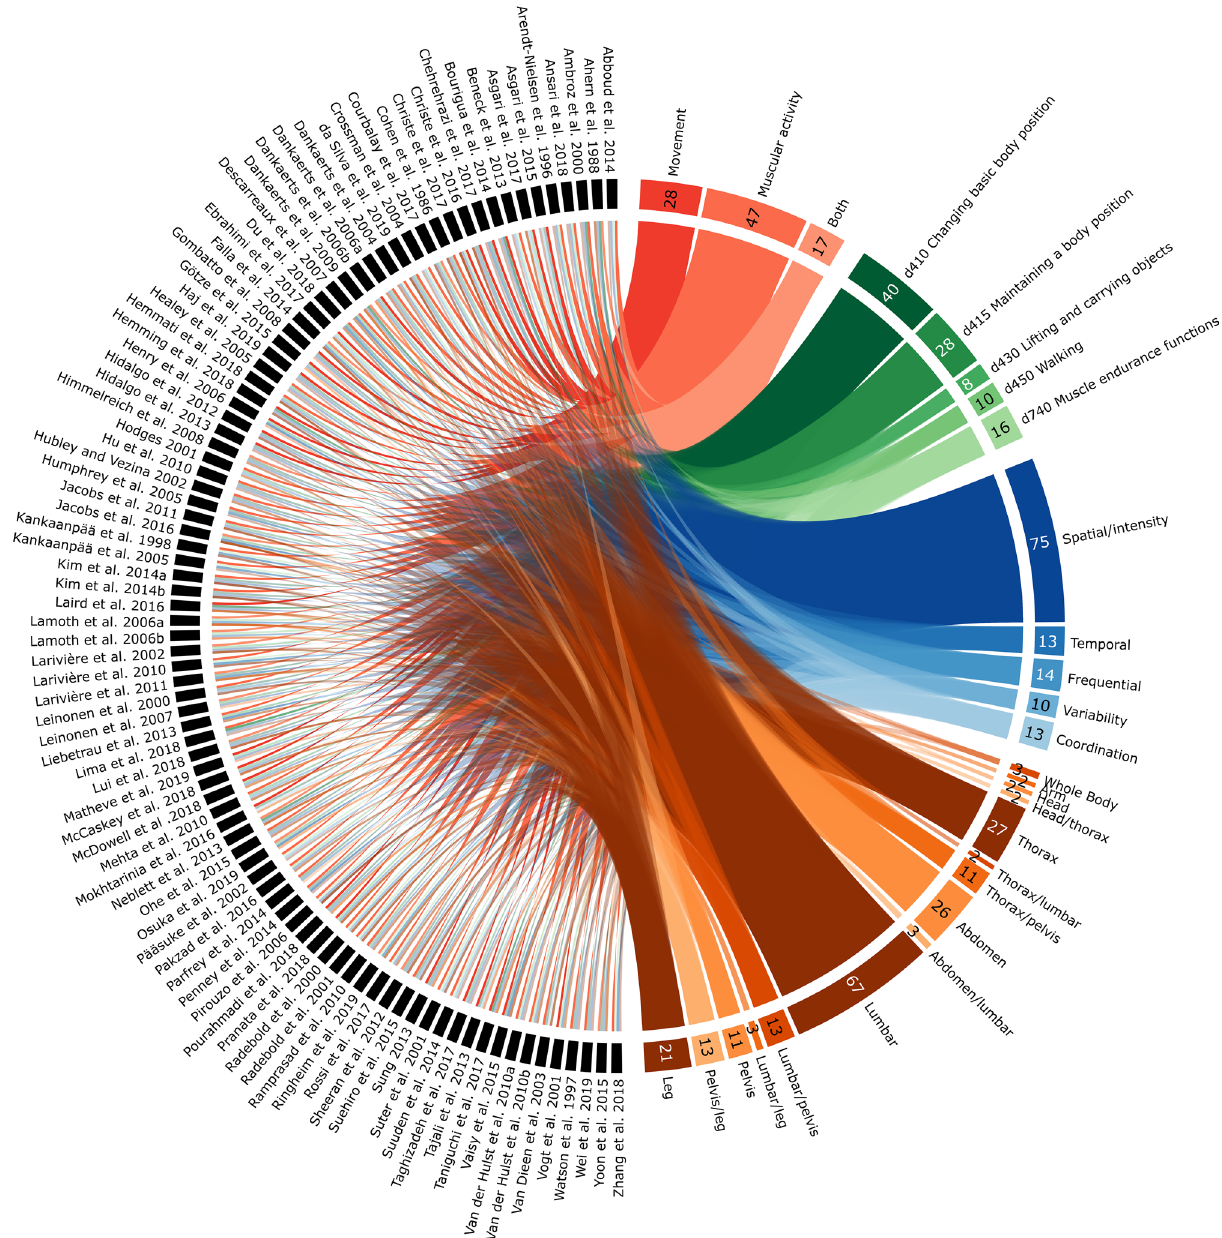
Figure 3. Circos plot 55 linking the included studies to their selected parameter types, ICF 2nd level categories, variable categories and regions of interest. The number of studies linked to each item is also